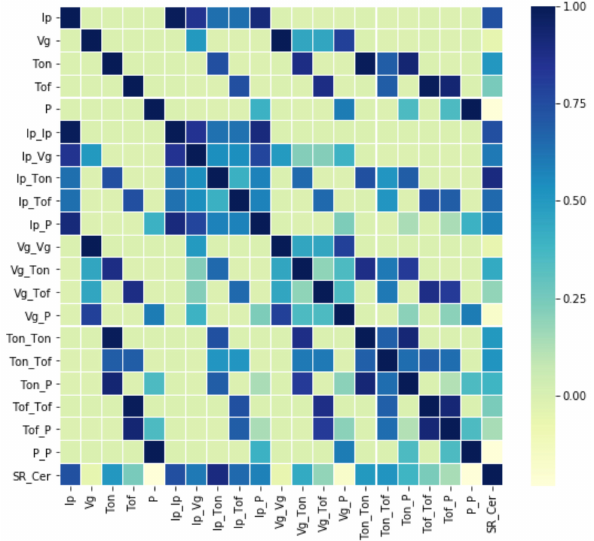
Figure 5. Heat map for SR. Table 4. Coefficients and probability for SR